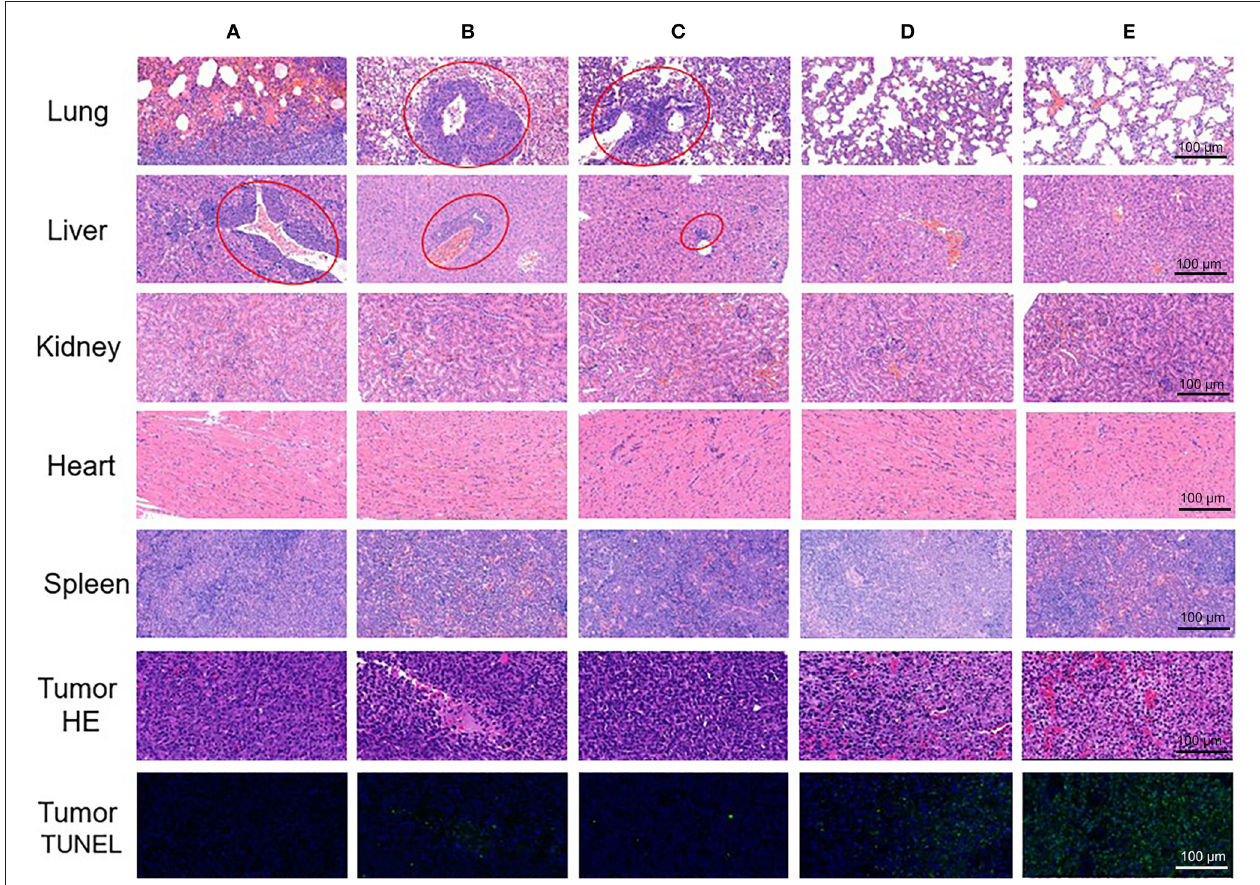
FIGURE 7 | The pathological slices of excised tumor and organs (lung, liver, kidney, heart, spleen) in control group (A) , free Ce6 group (B) , free CYC group (C) , ABN@HA-sese-Ce6 NPs group (D) , and ABN@HA-sese-Ce6/CYC NPs group (E) . Red circles represent tumor